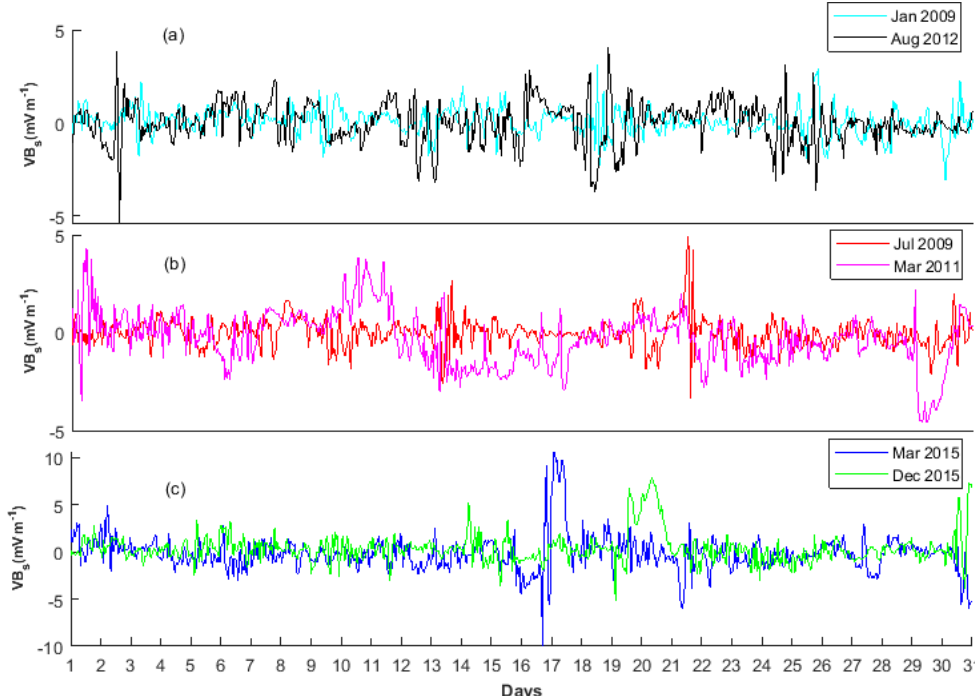
Figure 2. Samples of solar wind electric fields (VB s ) during (a) minor, (b) moderate and (c) major geomagnetic